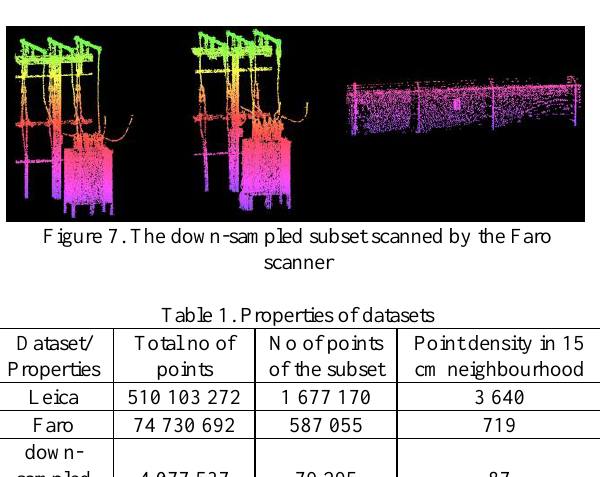
Figure 6. The subset scanned by the Faro scanner (with original point density)